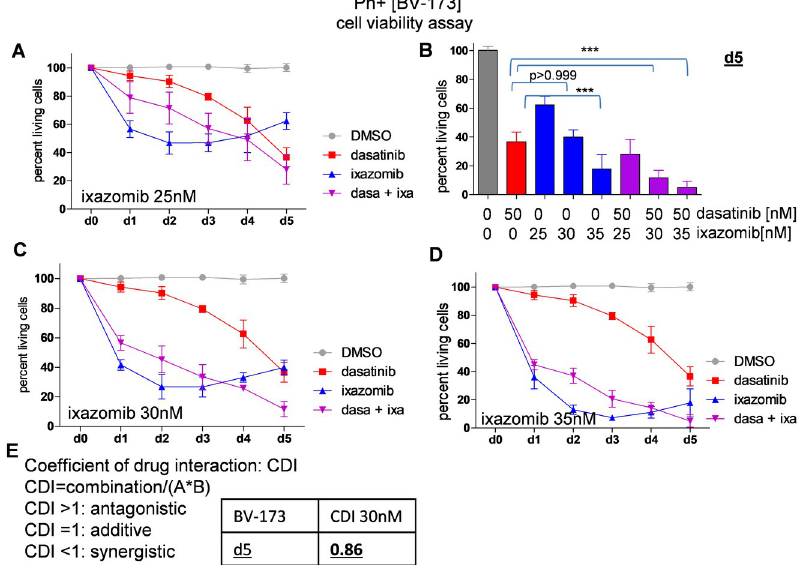
Fig 3. Combination treatment reduces cell viability and induces apoptosis in BV-173. Ph+ cells BV-173 were seeded with DMSO, dasatinib 50nM, ixazomib 25nM, 30nM, 35nM and the respective combination at day 0, drugs were replenished every third day. Viability was measured every 24h up to day 5 by PI staining assay. Recovery of cell viability was observed with ixazomib treatment despite drug replenishment for all ixazomib concentrations. (A) Treatment with dasatinib 50nM + ixazomib 25nM leads to a continuous reduction of the viability of BV-173, ixazomib only treated cells recover after day 3. (B+C) Single and combination treatment ixazomib 30nM: The treatment with ixazomib 30nM induced a strong reduction of viability to only 26.85 ± 8.29% of viable cells after two days of culture in the BV-173. Combination treatment of dasatinib and ixazomib 30nM led to a continuous reduction of cell viability ending up with only 11.71 ± 5.1% of viable cells on day 5. (D) Treatment with ixazomib 35nM reduces cell viability in single or combination treatment. (E) dasatinib 50nM + ixazomib 30nM: The calculated CDI was 0.86 on day 5, representing a synergistic effect of these two drugs in combination. (p values were calculated by one-way ANOVA with Bonferroni multiple comparison test. � ,p < 0.05, �� ,p < 0.01, ��� ,p < 0.001, error bars = SD, n = 3 for each treatment). Our BV-173 Ph+ ALL cells treated with ixazomib at 25nM also showed a significant differ- ence in viability compared to dasatinib single treatment on day 2 with 46.79 ± 7.8% of viable cells in the ixazomib mono-therapy group compared to still 90.37 ± 1.41% of viable dasatinib treated cells (Fig 3A and 3B). Again, a recovery of cell viability in the ixazomib only treated cells was observed after three days of drug exposure, with a viability of 62.35 ± 5.89% at day 5 (Fig 3A and 3B). At this time point the TKI effect outweighed the effects of proteasome inhibi- tion and no benefit of combination treatment was detected. (36.65 ± 6.76% cells viable with dasatinib alone and 27.97 ± 10.3% viable cells when combined with ixazomib) (Fig 3A and 3B). The cells were treated with 35nM ixazomib as well, showing similar results (Fig 3D). The TOM-1 cells were treated with ixazomib and dasatinib in the same manner. We obtained comparable results for 25nM and 30nM ixazomib in the PI Staining for TOM-1. For this reason, only the results for 25nM are described below. The viability of TOM-1 was signifi- cantly reduced by ixazomib single treatment as well as in combination with dasatinib (S7 Fig). With ixazomib at a concentration of 25nM, viability was reduced to 9.8 ± 4.45% in single and 6.2 ± 6.5% in combination treatment at day 5 (S7B Fig). Since we did not observe a significant dif- ference between both conditions a CDI could not be calculated. Ixazomib alone and combined with dasatinib showed a significantly stronger effect (p < 0.001) on cell viability than single treat- ment with dasatinib: 41.51 ± 14.22 of the dasatinib treated cells were still viable at day 5. We did not observe a significant recovery phenomenon of the cells in this specific context (S7A Fig).